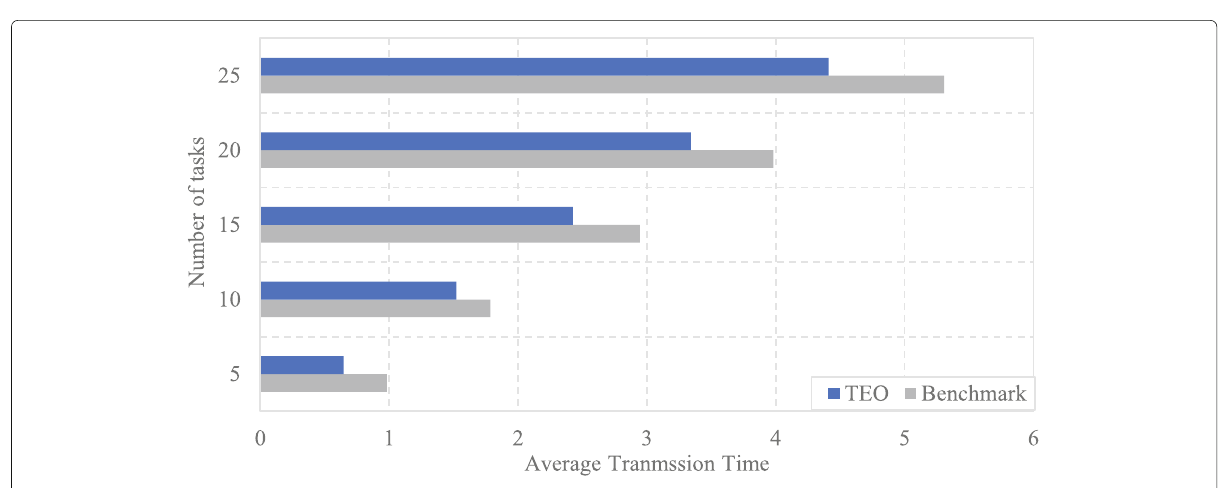
Fig. 9 Comparison of the average time consumption